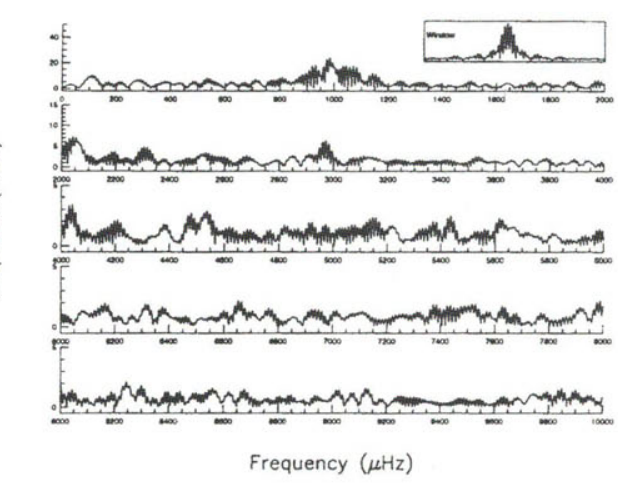
Fig. 14. The FT for the October 1990 data on G 38-29.